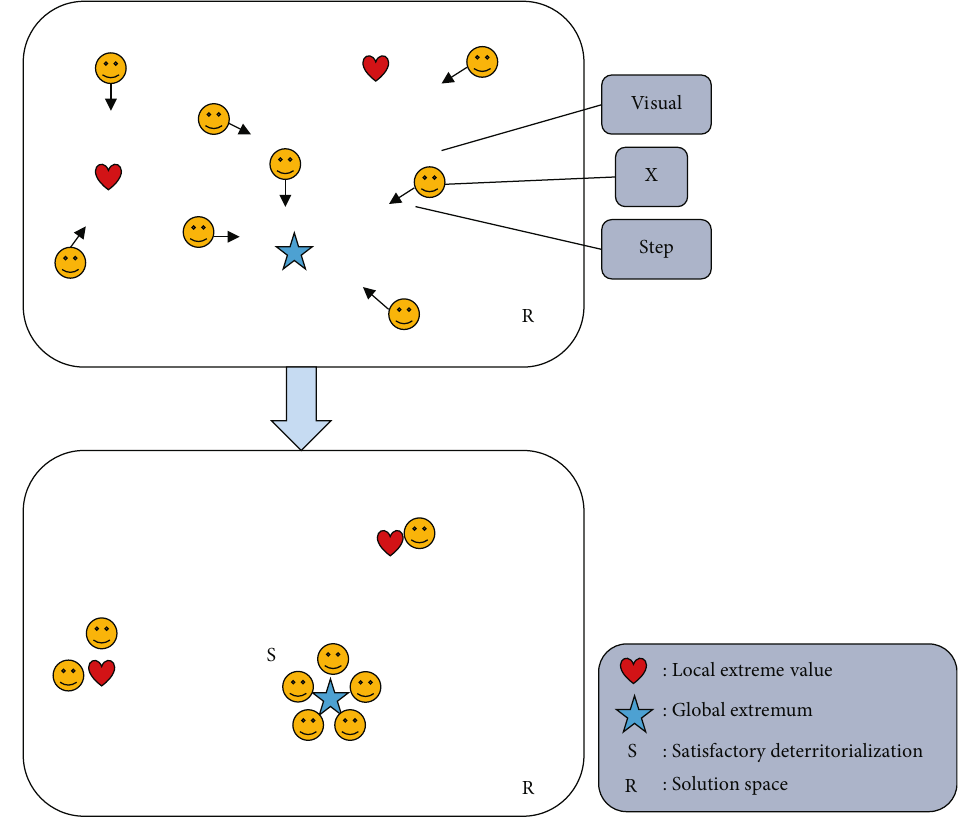
Figure 2: Schematic diagram of AFSA